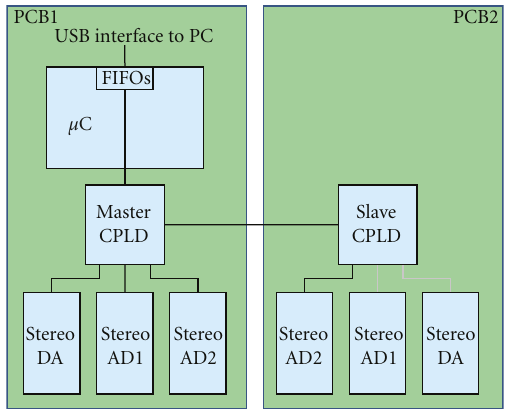
Figure 4: Architecture of the dedicated audio interface, with four inputs and two outputs (PCB1 only), or six inputs and two outputs (PCB1 and